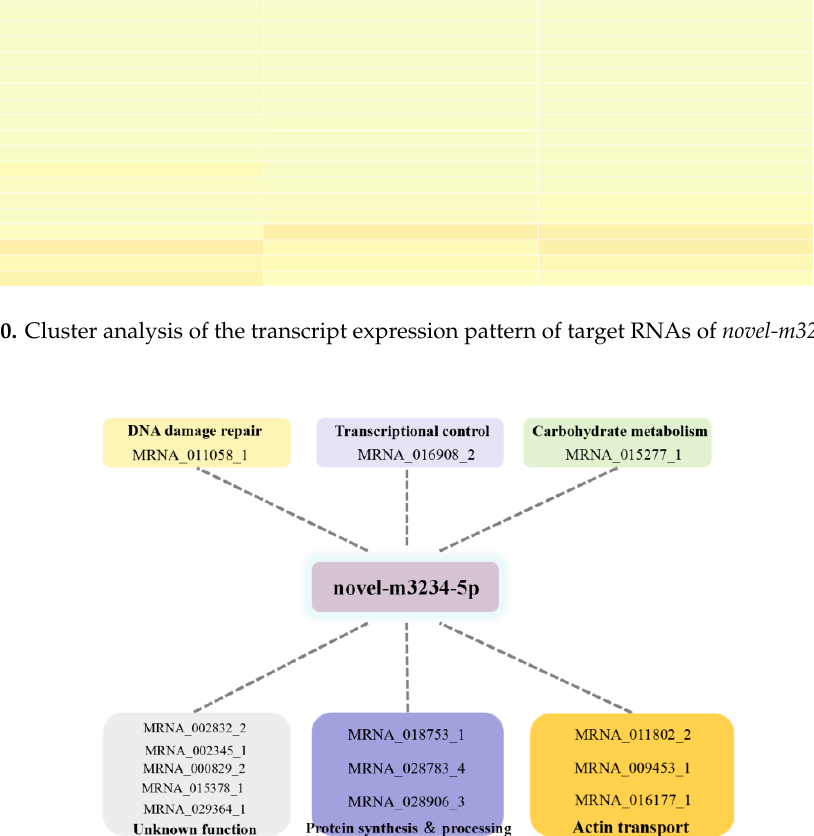
Figure 11. Functional annotation of competing endogenous RNAs of sjCRY-DASH that were targeted to novel-m3234-5p . Table 2. Complementary between novel-m3234-5p and mRNAs.